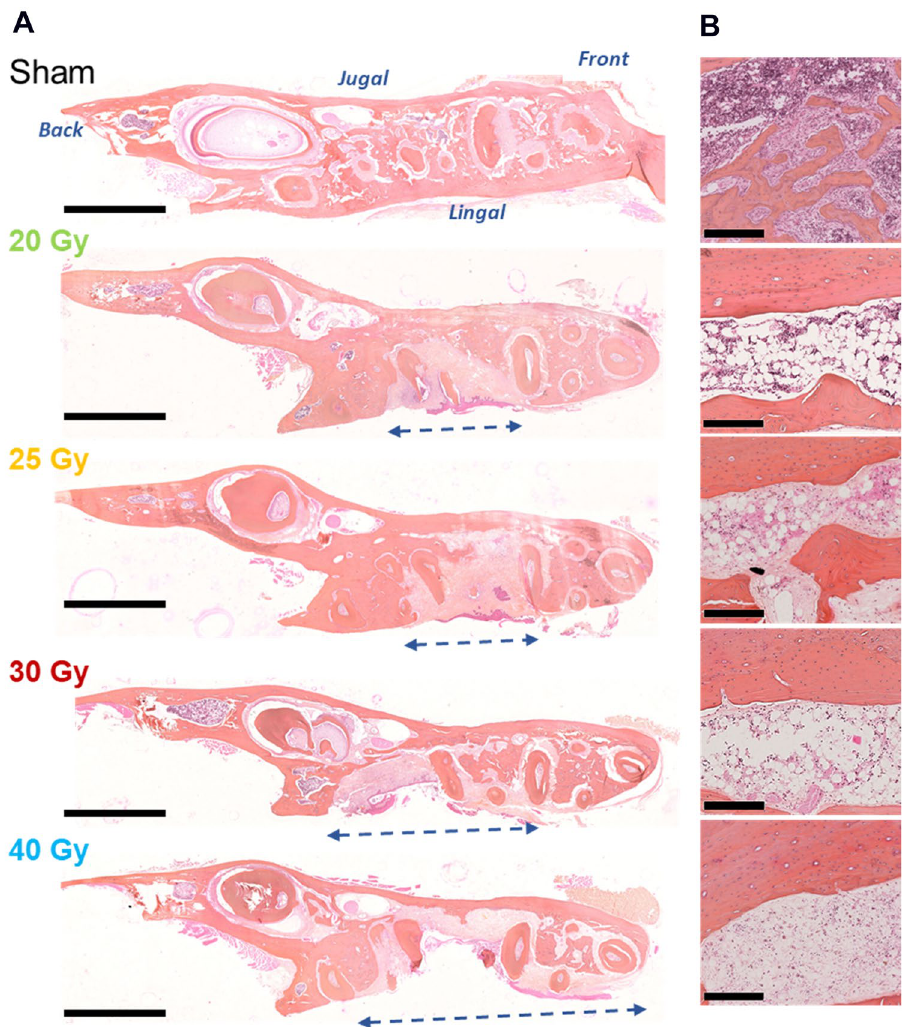
Figure 2. Histological analyses on transversal section of left mandibles. Representative HES staining in Sham and irradiated animals after 16 W. ( A ) of upper transversal series of the left mandible at different irradiation doses (alveolar side). Blue arrows show bone damage expansion for each irradiation dose. Scale bars represent 2.5 mm. ( B ) Bone and bone marrow composition (basal side). Scale bars represent 250